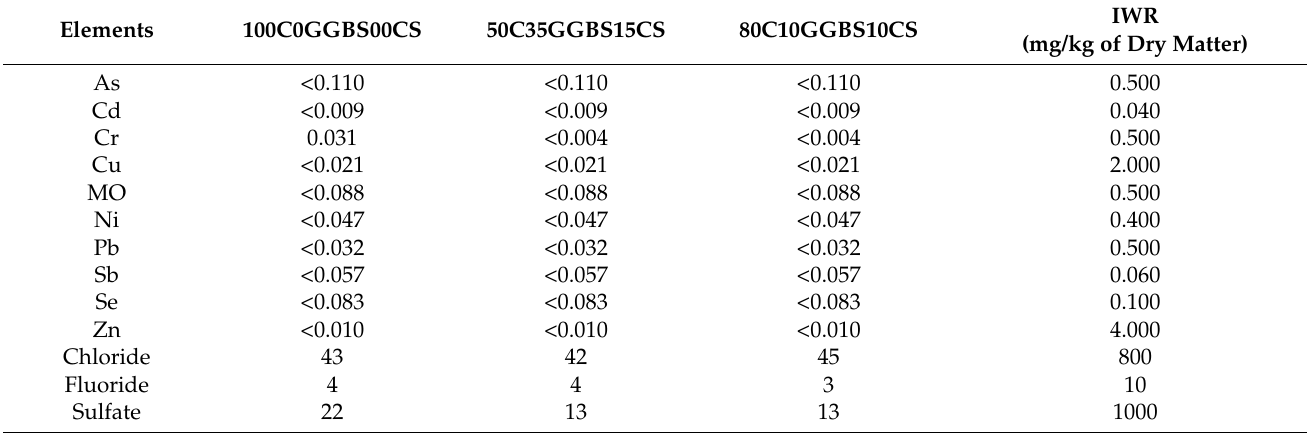
Table 12. Eluate element concentrations compared to inert waste leching limit values (French Directive of 14 December